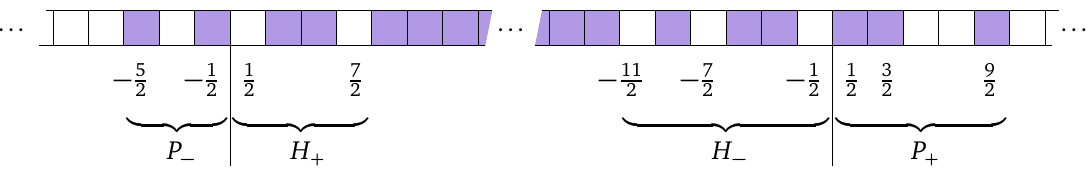
Figure 2: Picture of particle-hole excitations at both edges of the Fermi sea corre- sponding to sets P , H of half-integers. The notations P ± , H ± indicate the positive and negative elements of the